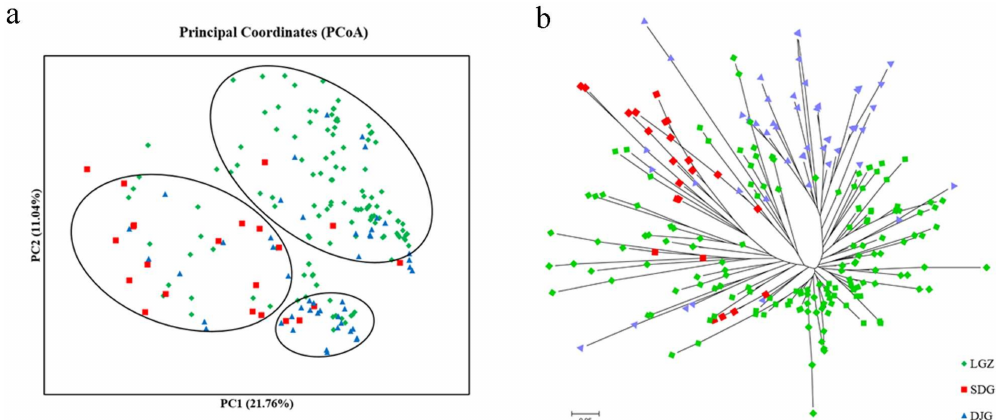
Figure 5. Principal coordinate analysis (PCoA) ( a ) and neighbour-joining (NJ) tree ( b ) of the 232 T . koraiensis individuals. PC1: the first principal coordinate; PC2: the second principal